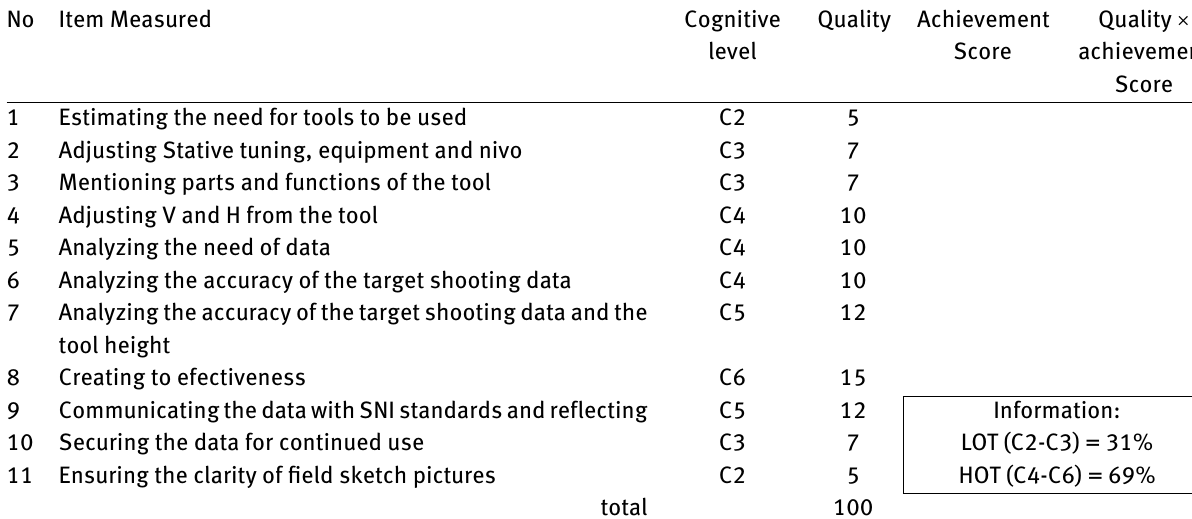
Table 1: Evaluation Outline of Process to Acquire V-HOT Skills No Item Measured